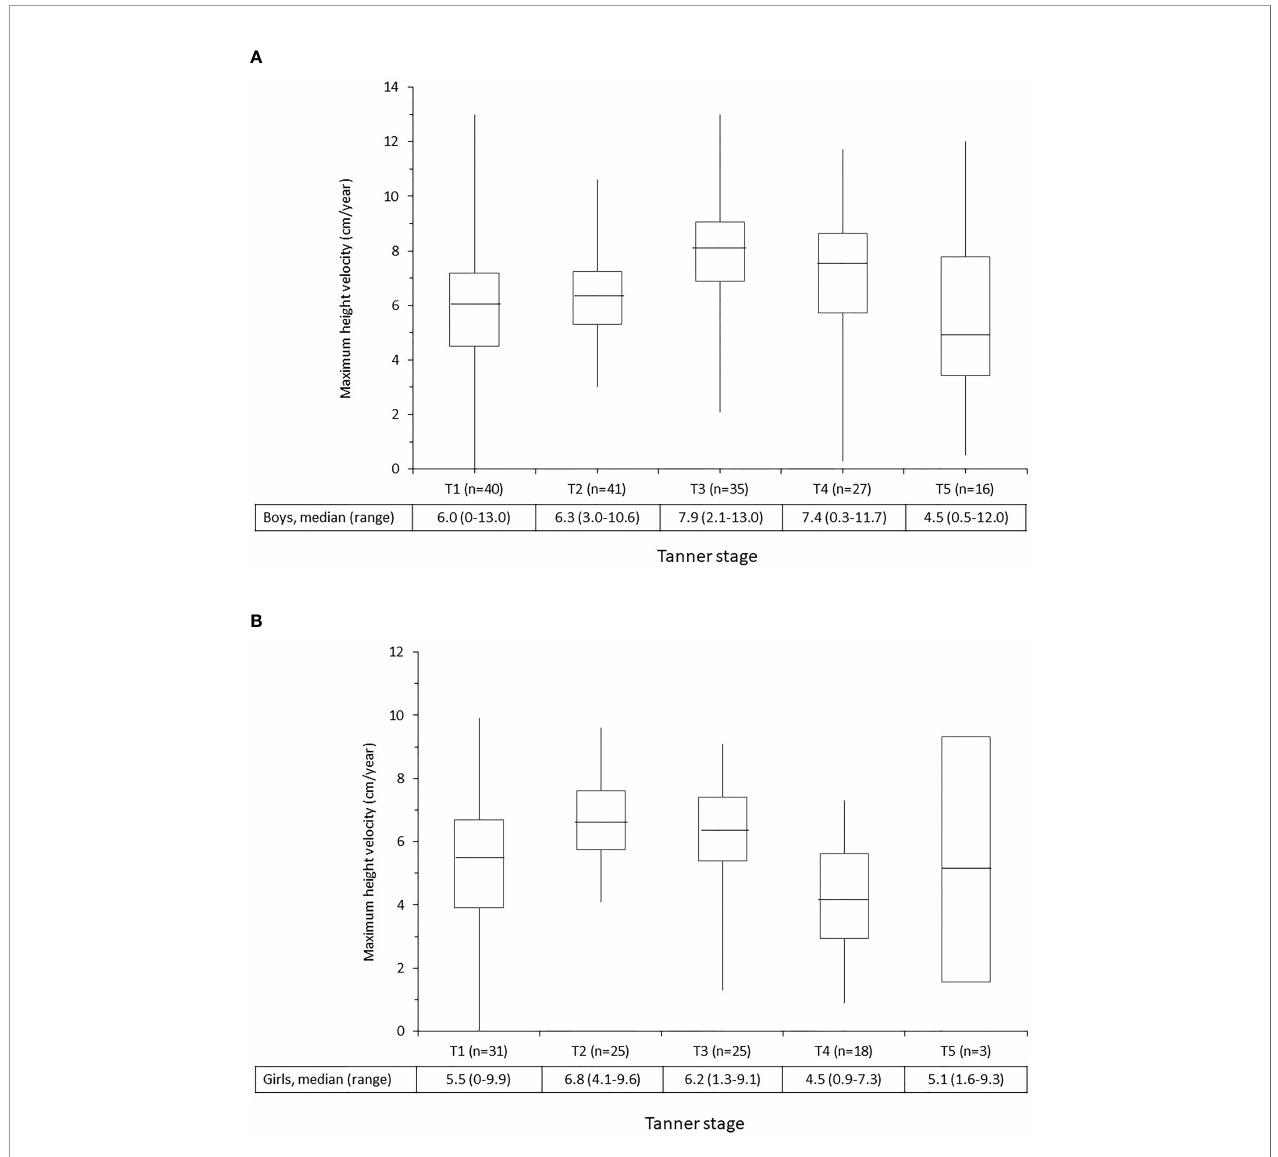
FIGURE 2 | Maximum height velocity at each Tanner stage in children receiving rhIGF-1 for growth failure. (A) Boys. (B) Girls. The middle box represents the interquartile range; the mid-line represents the median value. The upper/lower whiskers represent the upper and lower quartiles. SPIGFD, severe primary insulin-like growth factor-1 de fi